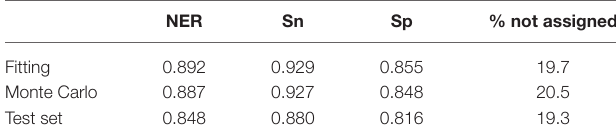
TABLE 3 | Performance of the QSTR-based expert system based on the “ strict ” consensus . NER Sn Sp % not